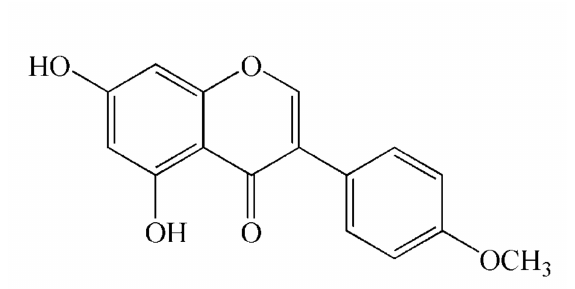
Figure 1. The chemical structure of biochanin